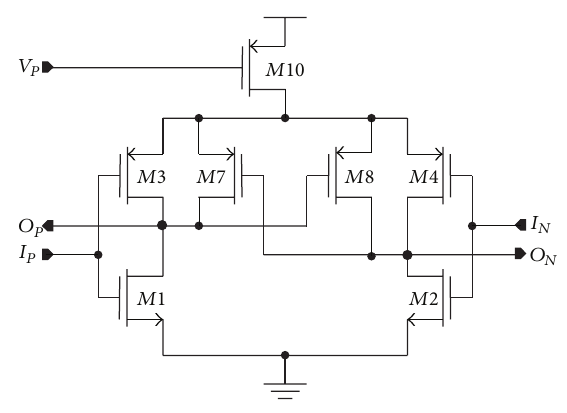
Figure 15: Delay cell circuit diagram